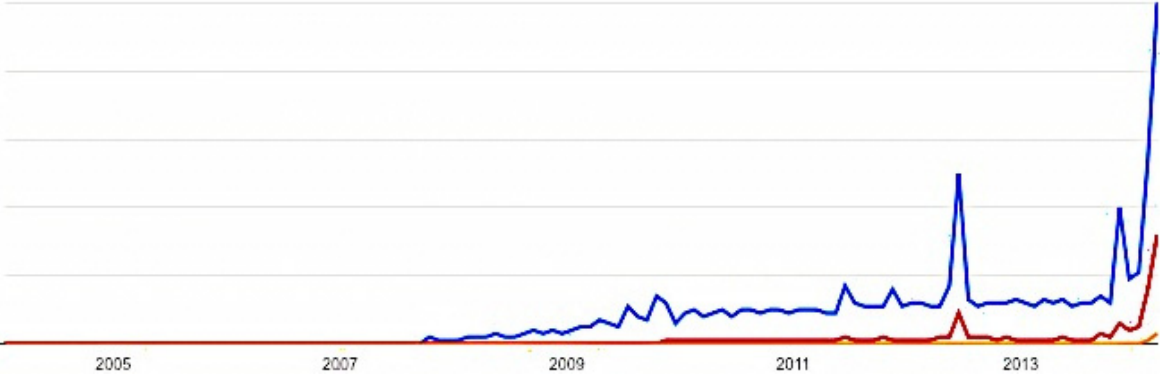
Figure 4. The number of Internet users in Ukraine and some Arab countries, per 100 people. Source : World Bank 2014.